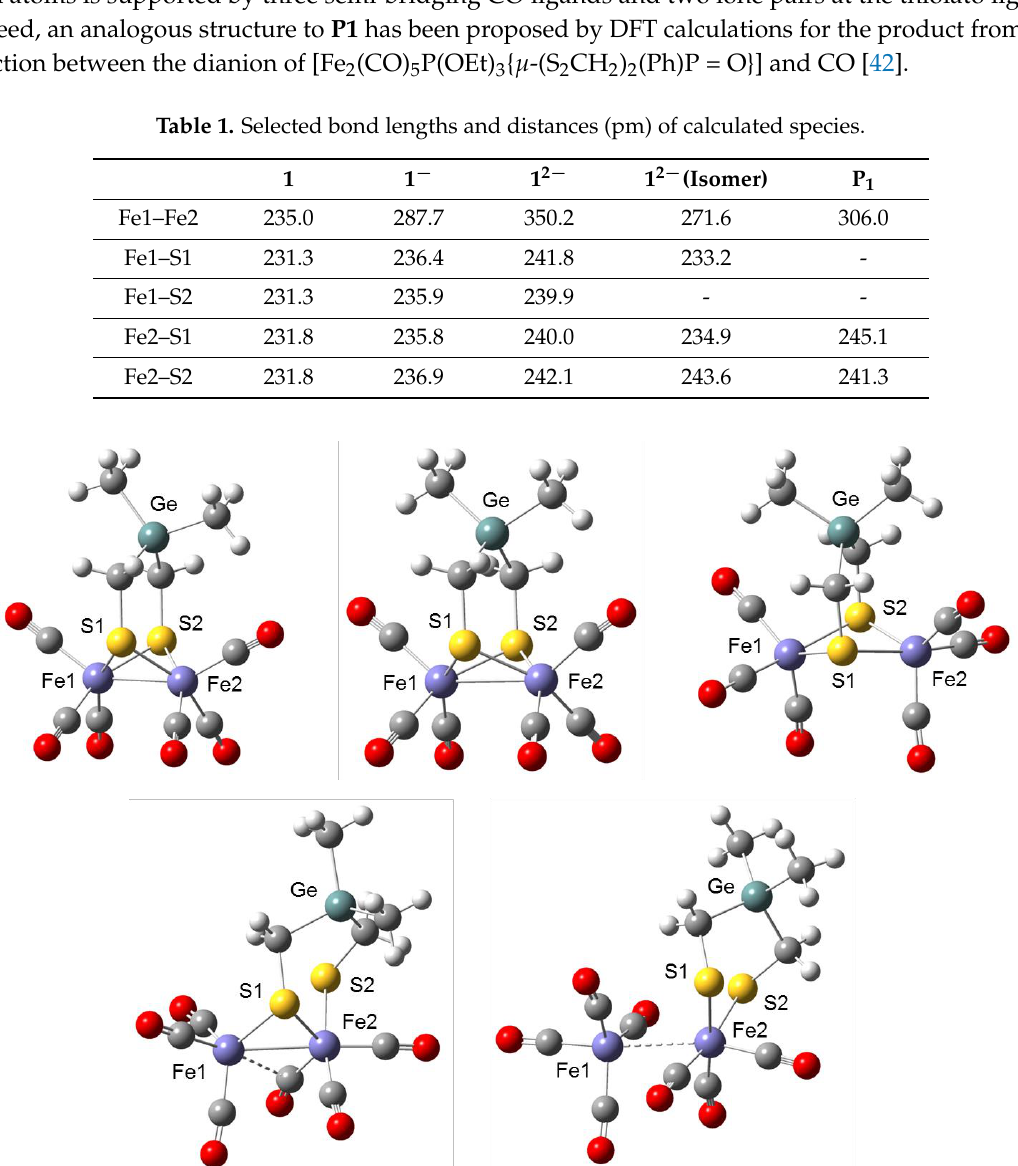
Figure 3. Calculated molecular structures of 1 (upper left), 1 − (upper middle), 1 2− (upper right), 1 2− (isomer) (lower left), and P 1 (lower right). Table 1. Selected bond lengths and distances (pm) of calculated species.